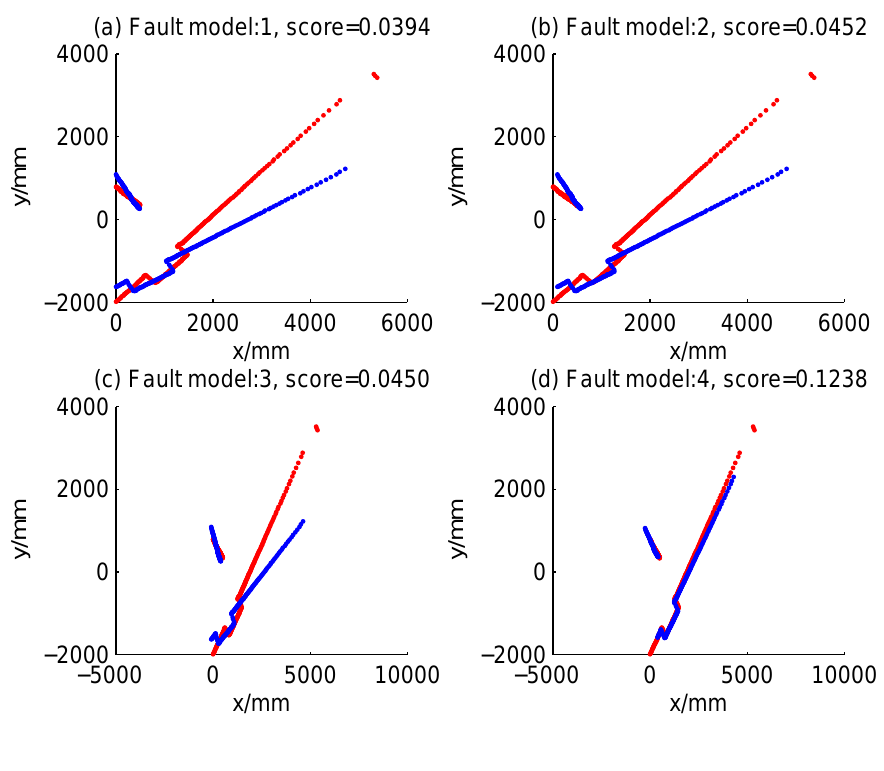
Figure 22. Case 4b: Gyroscope stuck, fault model = 4 (time Step 17).